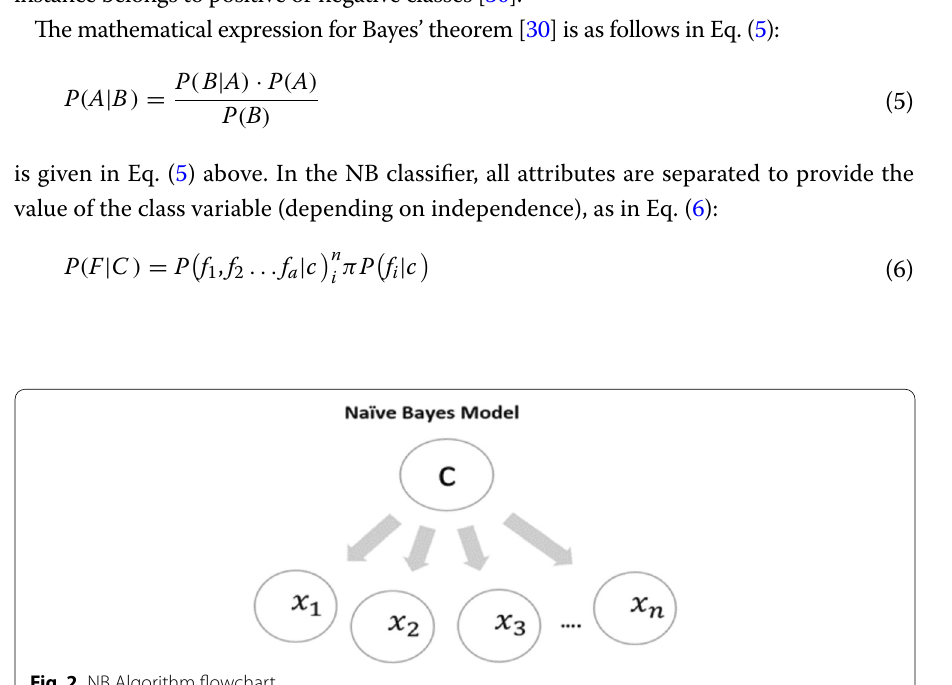
Fig. 2 NB Algorithm